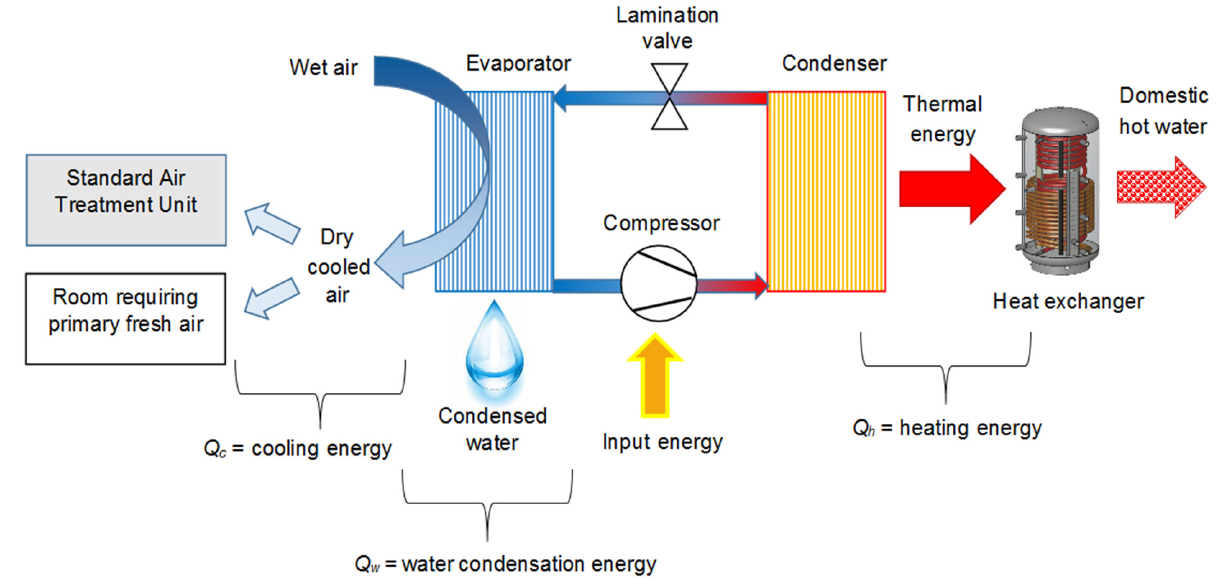
Figure 1. Example of an AWG integrated system scheme.